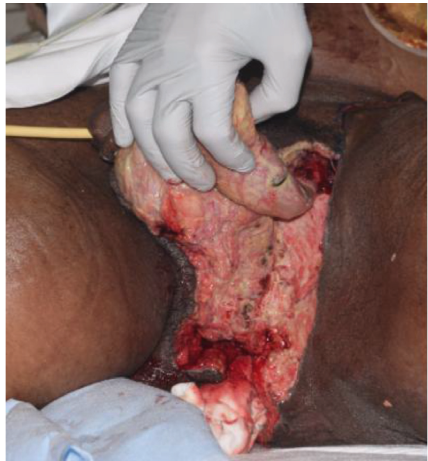
Figure 4: Photographic image of the perineum and scrotum post debridement of involved skin and subcutaneous tissue and packing at the perineal level extending into the pelvis.